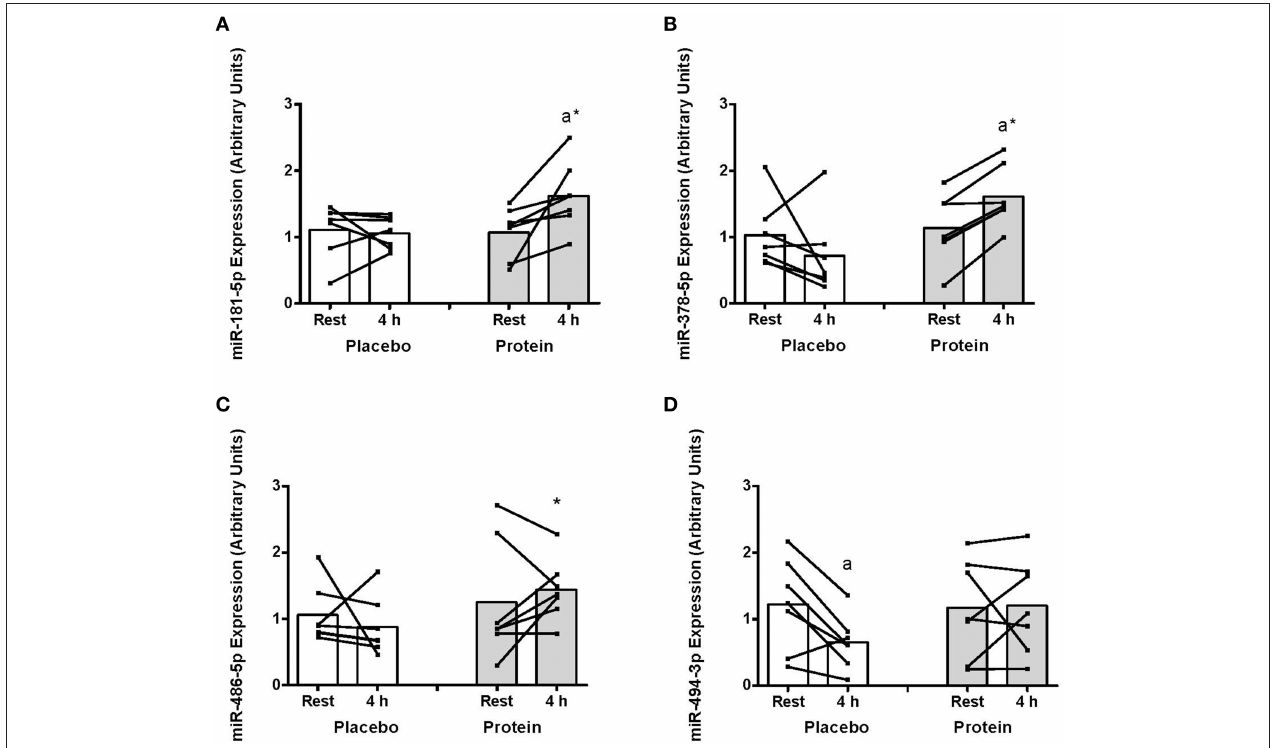
FIGURE 2 | (A) mir-181-5p, (B) miR-378-5p, (C) miR-486-5p, and (D) miR-494-3p abundance at rest and at 4h post-exercise recovery following a concurrent exercise session of resistance (8 sets of 5 leg extension at 80% 1-RM) and endurance (30min cycling at 70% VO 2peak ) exercise and ingestion of either 500-mL PLA or PRO beverage immediately after exercise. Values are arbitrary units expressed relative to RNU48 and presented as individual data with group mean ( n = 7 ). Significantly different ( P < 0.05 ) vs. (a) rest and ( * ) between treatments (PLA vs.